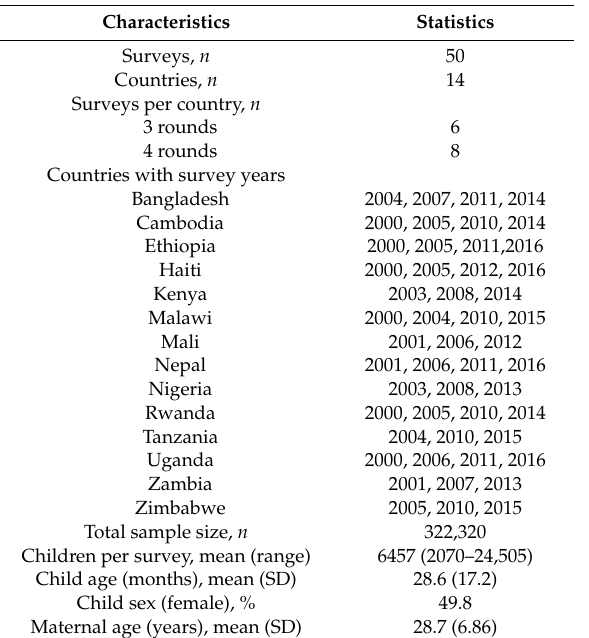
Table 2. Characteristics of included Demographic and Health Surveys.